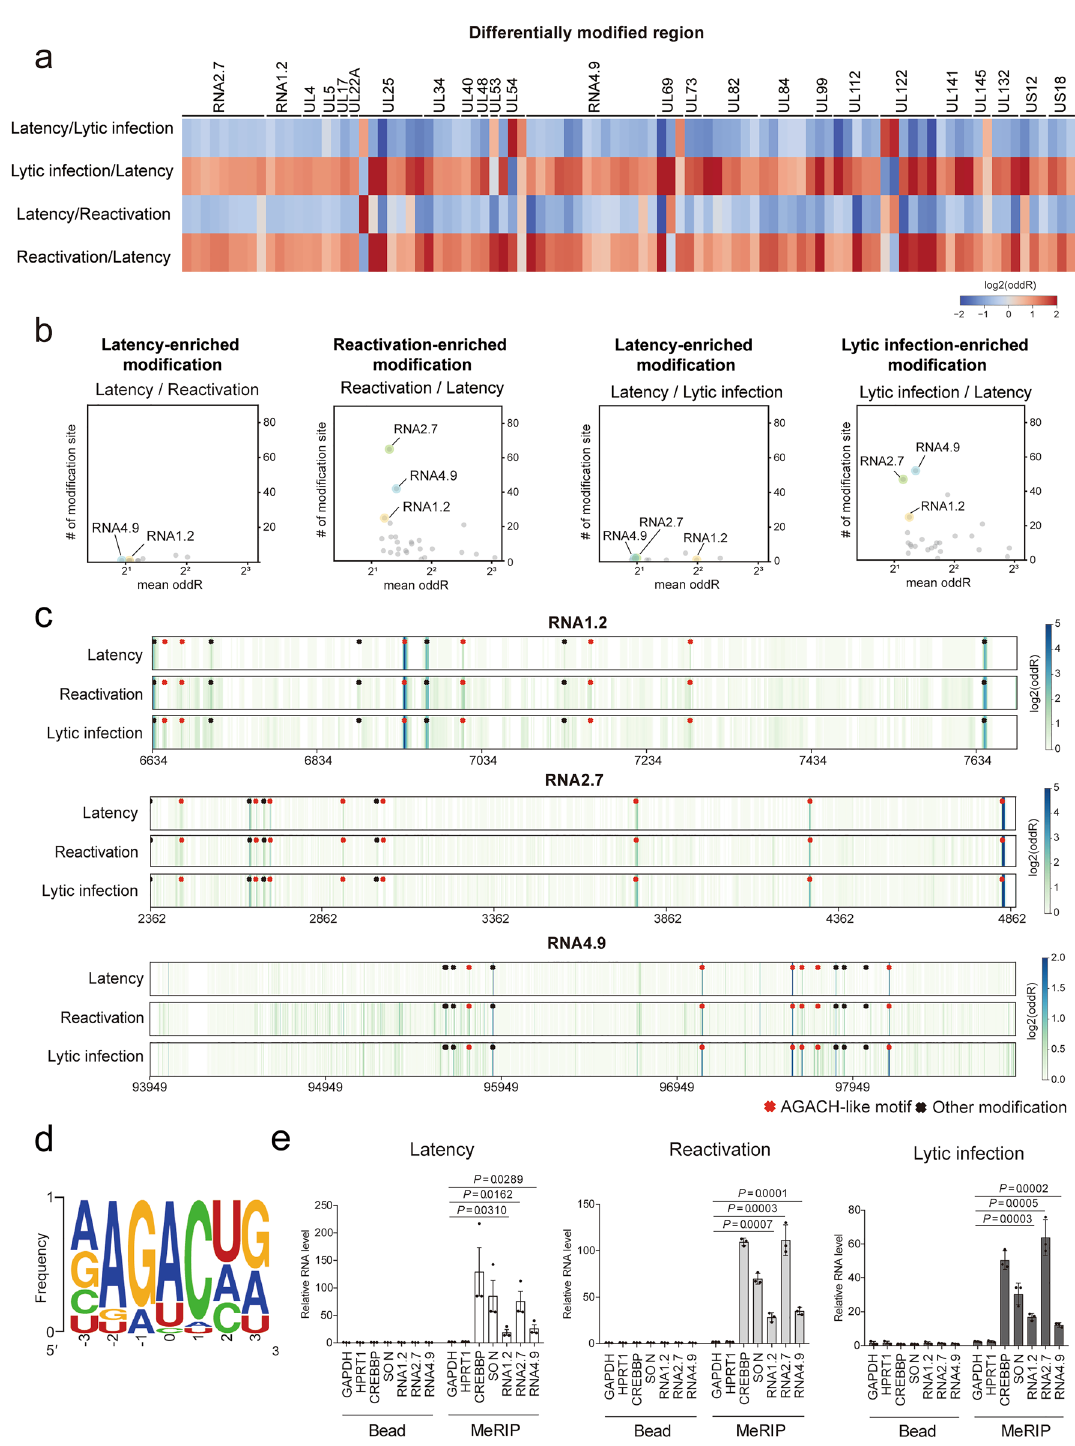
Figure 4. Post-transcriptional landscape of HCMV transcripts throughout the viral life cycle. ( a , b ) Differentially modified regions in viral transcripts. In comparison of test and control groups (test/control), enriched modification score (odds ratio) was analyzed by ELIGOS2. ( a ) Viral transcripts were divided into 300 nt tiles, and the median log 2 odds ratio for each tile is presented as a heatmap. ( b ) Scatter plot showing the relationship between number of differential modification sites (odds ratio > 1.8) and average odds ratio for each gene. ( c ) Location and modification levels of RNA1.2, RNA2.7, and RNA4.9 in latency, reactivation, and lytic infection. Putative modification sites (odds ratio > 1.8) with AGACH motifs (red) and the others (black) are marked. ( d ) Position-specific base frequency of a motif enriched in the putative modified sites. ( e ) MeRIP-qPCR of latency, reactivation, and lytic infection samples. HPRT1 and GAPDH served as m 6 A-negative controls. CREBBP and SON served as m 6 A-positive controls. Data represent mean ± SEM. All experiments were performed independently (n = 3), and the statistical significance was calculated by two-tailed unpaired t